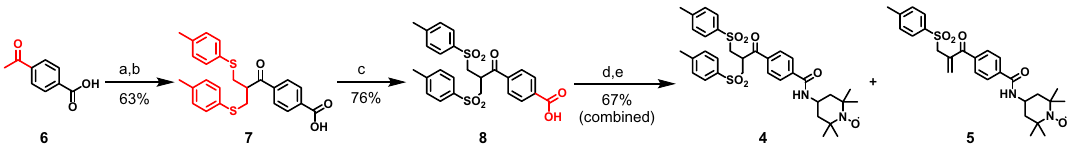
Scheme 2. Synthesis of the intercalator mixture 4 and 5. (a) Paraformaldehyde, dimethylamine hydrochloride, isopropanol, reflux, 24 h; (b) 4-methylthiophenol, isopropanol/H 2 O, RT, 24 h; (c) H 2 O 2 , AcOH, 30